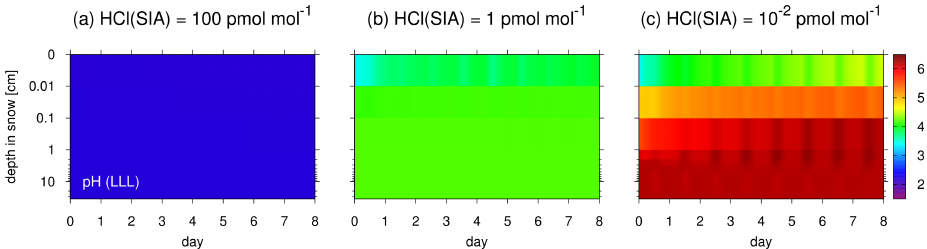
Fig. 12. Time-height cross sections for simulated pH in the LLL on the surface of snowpack grains from model runs in which gas-phase HCl mixing ratio in the SIA is fixed deliberately at 100pmolmol − 1 (a) , 1pmolmol − 1 (b) , and 0.01pmolmol − 1 (c) , while in the ambient air it is fixed at 100pmolmol − 1 for all the cases.